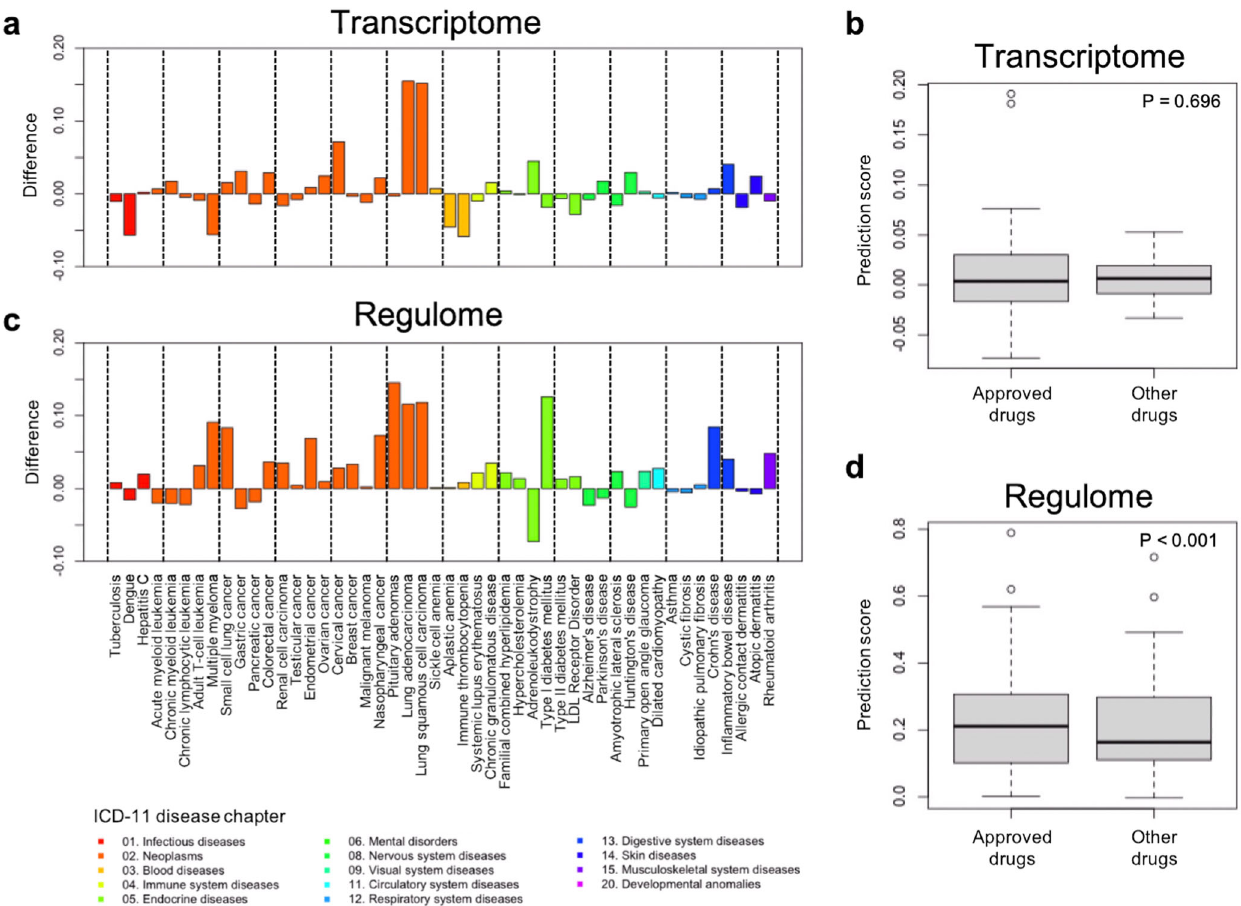
Fig. 4 Performance evaluation for drug indication prediction. a Difference between the prediction scores for approved drugs and those for other drugs by the transcriptome-based prediction. b Distribution of prediction scores for approved and other drugs by the transcriptome- based prediction. c Difference between the prediction scores for approved drugs and those for other drugs by the regulome-based prediction. d Distribution of prediction scores for approved and other drugs by the regulome-based prediction. The positive difference means the prediction scores for approved drugs are larger than those for other drugs. Bars are colored according to the ICD-11 disease chapters. All P -values were determined by the Wilcoxon signed-rank test. In the box plots: center line, median; box, interquartile range; whiskers, 1.5× interquartile range; dots,